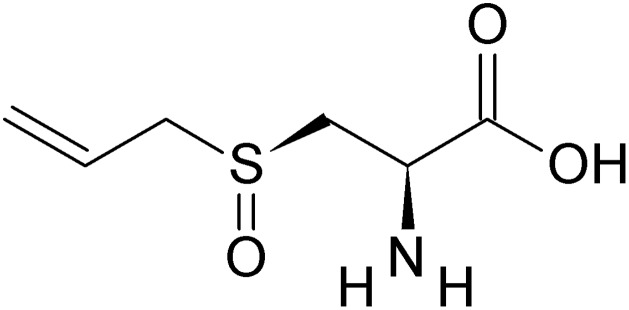
Structure of alliin.